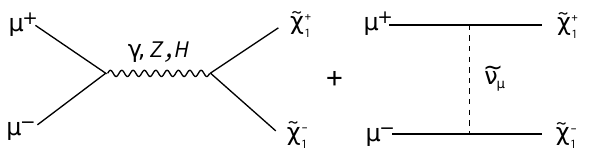
FIG. 9. Diagrams for production of the lighter chargino.